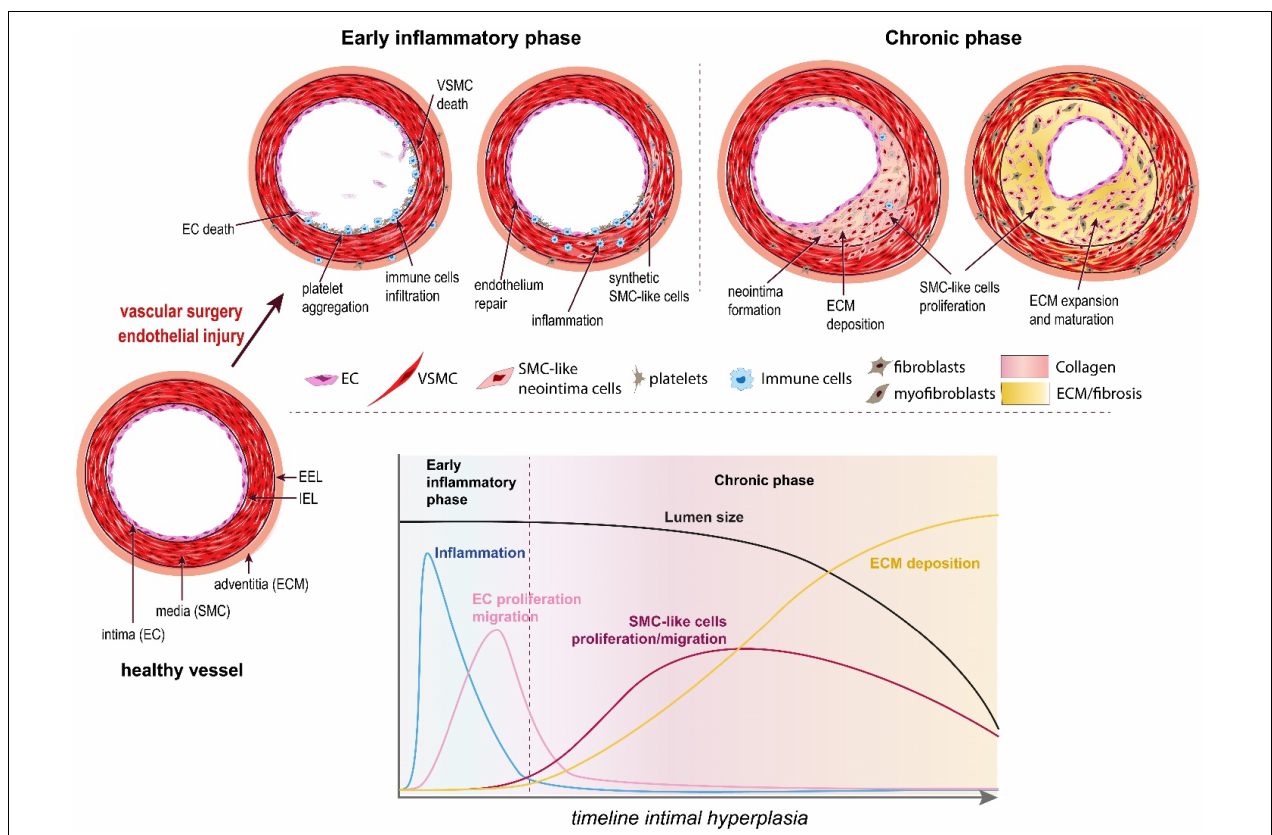
FIGURE 2 | The pathophysiology of intimal hyperplasia. IH is triggered by endothelial injury, which activates platelets aggregation, and recruitment and activation of immune cells in the arterial wall (early inflammatory phase). The platelets and immune cells release cytokines, chemokines and growth factors, which stimulate a wound healing response mediated by SMC-like cells (mostly synthetic SMC derived from medial VSMC and myofibroblasts derived from adventitial fibroblasts). These synthetic SMC-like cells proliferate and migrate under the internal elastic lamina (IEL), forming the neointima layer. Long after inflammation is resolved and the endothelium is repaired (chronic phase), these cells continue to secrete extracellular matrix (ECM), leading to the progressive narrowing of the